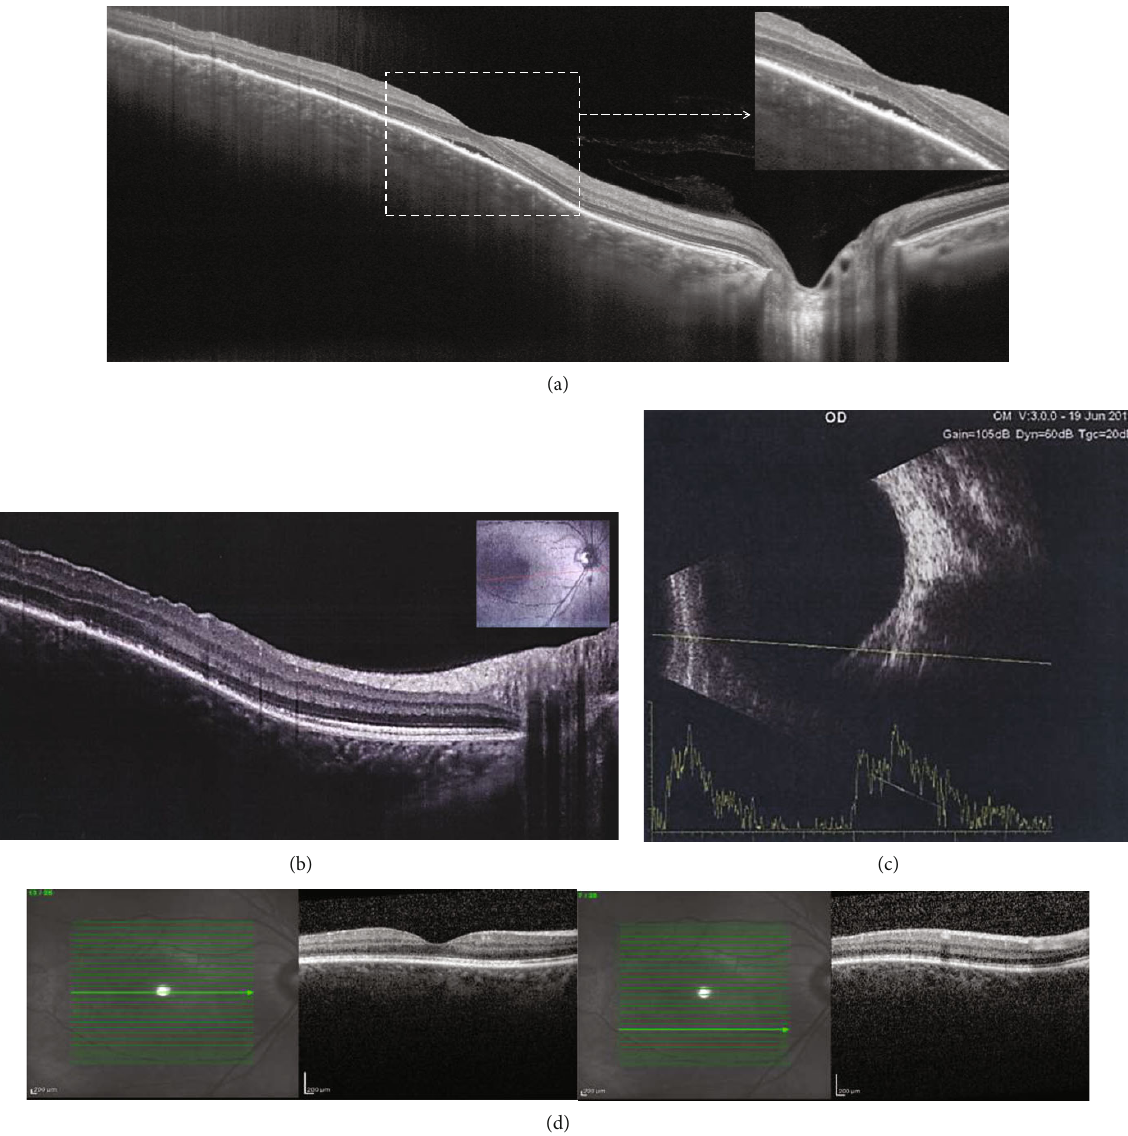
Figure 2: Follow-up examinations. Optical coherence tomography two weeks after initial presentation showed improvement of subretinal fl uid, decreasing the size of the choroidal mass, disruption of the ellipsoid zone, and accumulations of hyperre fl ective material of variable size and shape under the fovea (a) and the corresponding retina over the choroidal mass (b). Ultrasonography two weeks after the initial presentation revealed decreasing the size of choroidal mass (c). OCT one month after initial presentation showed near-complete resolution of choroidal mass and SRF, EZ restoration, and disappearance of hyperre fl ective materials over RPE and outer